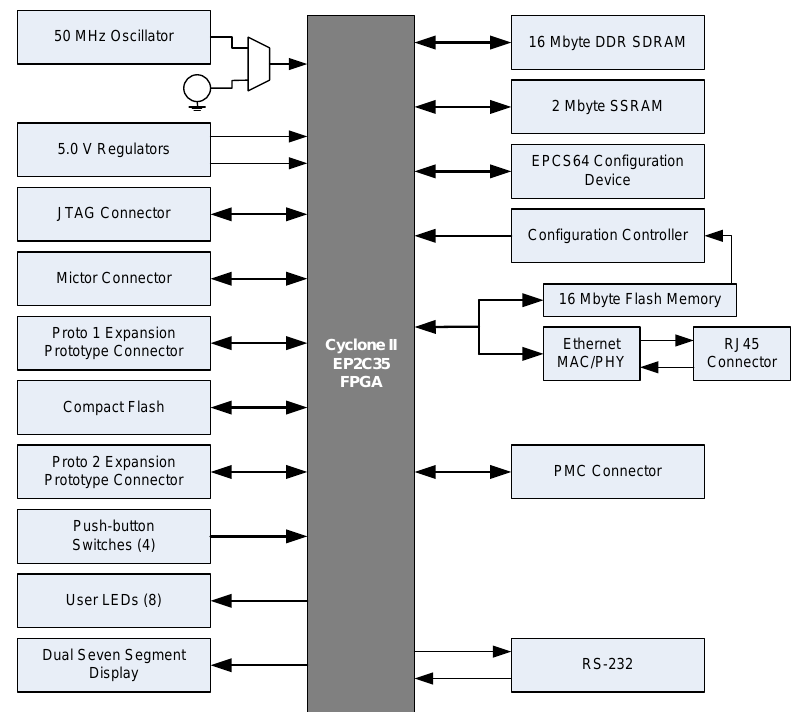
Figure 2. Development board